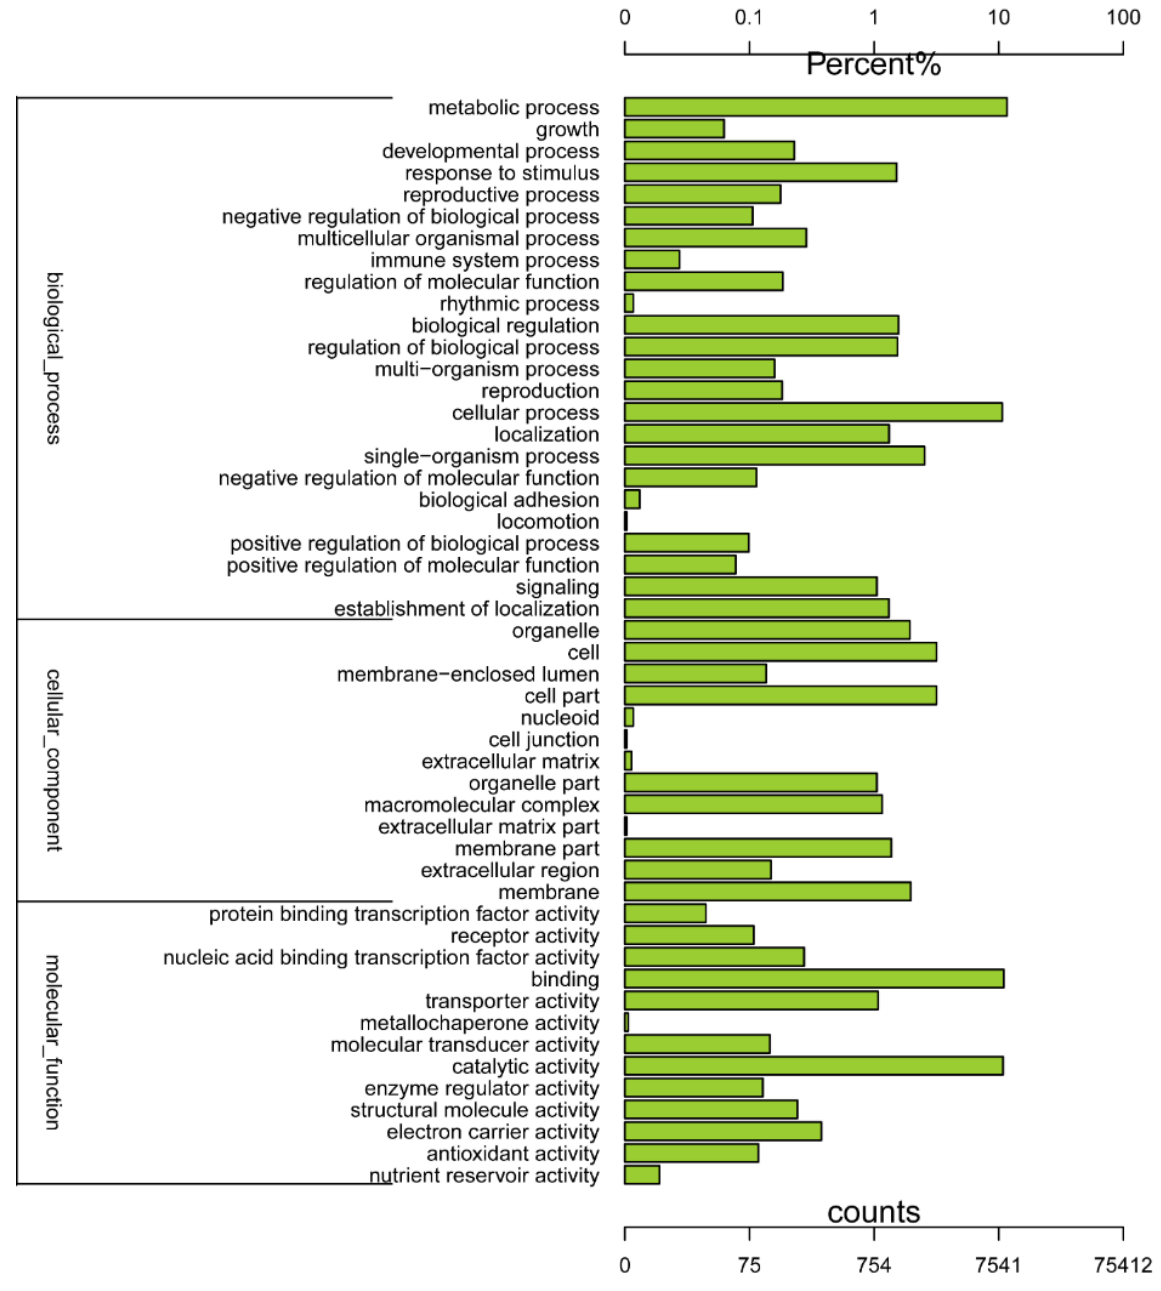
Figure 2. Gene Ontology functional classification. The classifications are shown in three main categories and fifty